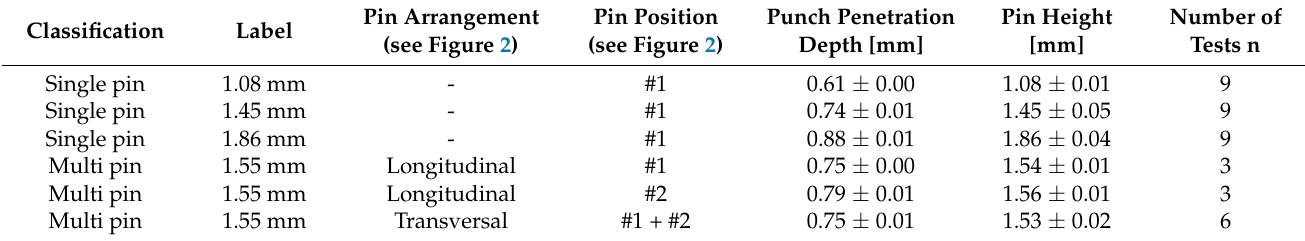
Table 4. Achieved pin height in relation to punch penetration depth, number of pins, and pin arrangement.